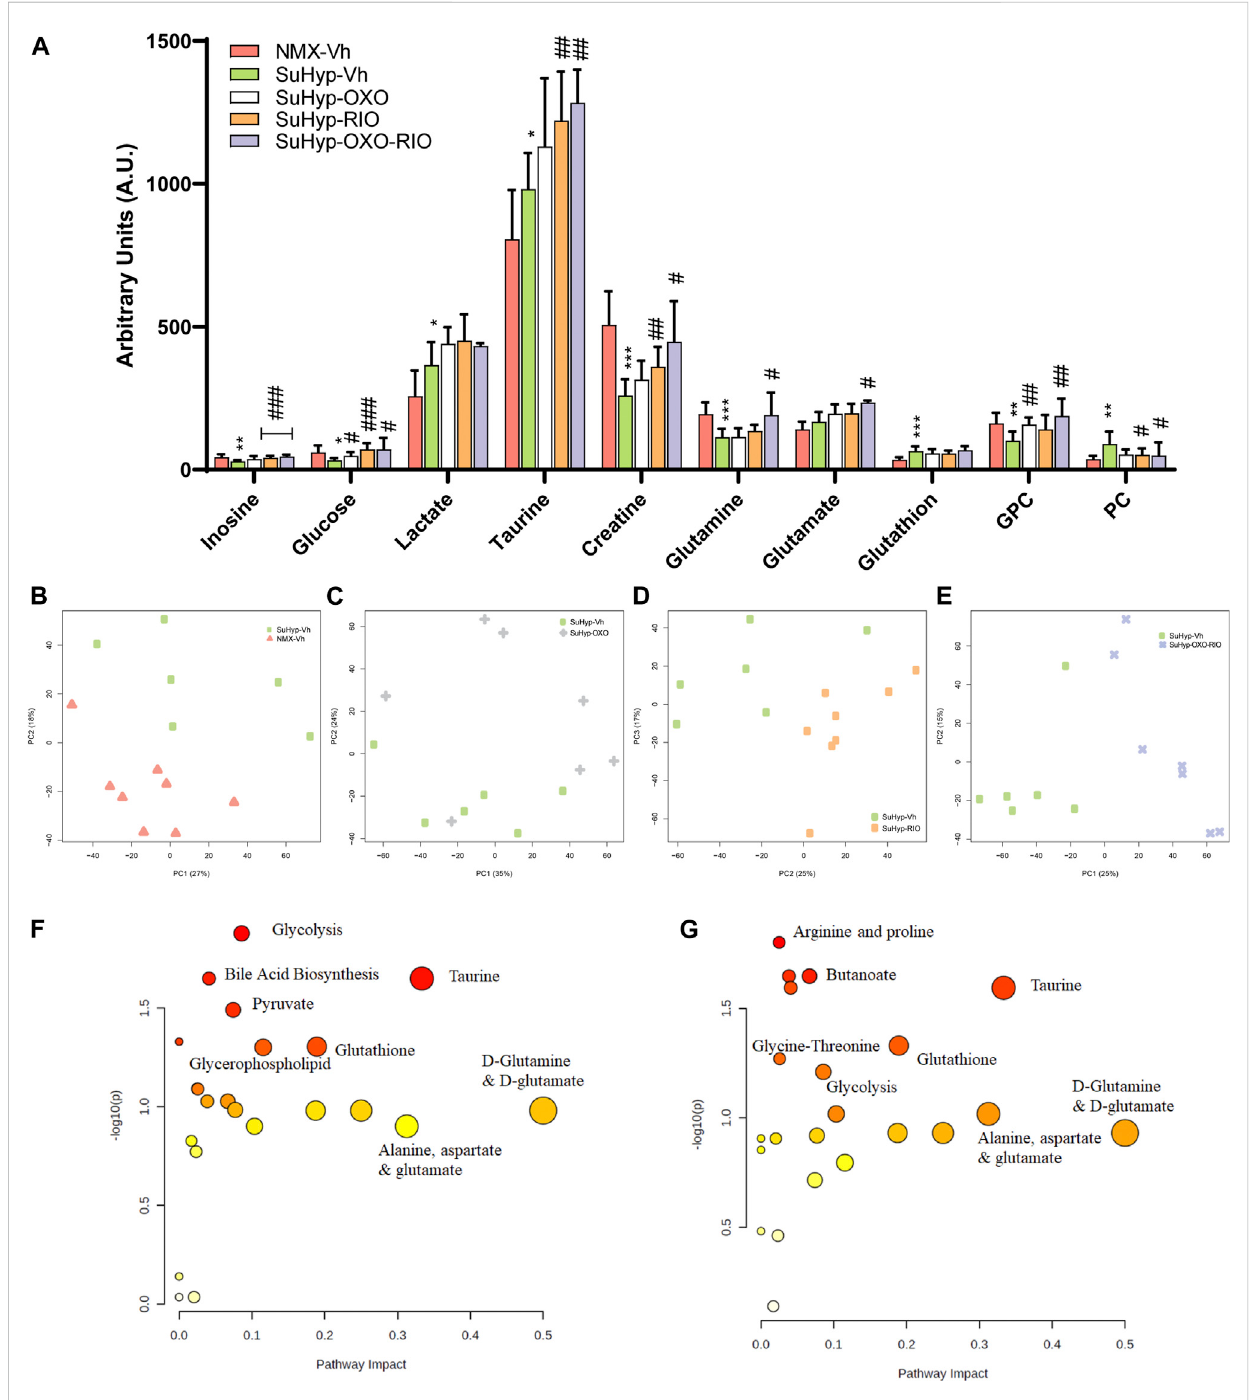
FIGURE 3 Treatment with riociguat and 5-Z-7oxozeaenol reduces metabolic reprogramming in the right ventricle (RV) from SuHyp rats. (A) Metabolomic pro fi ling of RV samples showing the quanti fi cation of metabolites signi fi cantly altered between the fi ve intervention groups. Statistical signi fi cance was determined using a Bonferroni-corrected Student ’ s t-test (* p < 0.05 versus normoxia + vehicle and # p < 0.05 versus SuHyp + vehicle). (B) Metabolic pro fi ling of RV samples discriminated between SuHyp and control groups as shown by principal components analysis (PCA) performed on 1 H-MRS data. Treatment with (C) 5Z-7-oxozeaenol, (D) riociguat or (E) both drugs combined induced a signi fi cant metabolic shift in the SuHyp RV. (F) Metabolic pathway analysis of the set of metabolites found to be signi fi cantly dysregulated between control and SuHyp rats (G) Incidence of the combined treatment with 5Z-7-oxozeaenol and riociguat on the SuHyp group over the speci fi c metabolic pathways. Y -axis represents the statistical p values from enrichment analysis, and the X -axis represents the pathway impact value calculated from pathway topology analysis. The node colors represent the p -values (lowest: light yellow; highest: dark red) and the node radius indicate the pathway impact values. Dysregulated metabolic pathways are labeled. Control group: NMX-Vh, Sugen 5,416/hypoxia: SuHyp, SuHyp + 5Z-7-oxozeaenol treatment: SuHyp-OXO; SuHyp + riociguat treatment: SuHyp-RIO; SuHyp+ 5Z-7-oxozeaenol and riociguat treatment: SuHyp-OXO-RIO, PC: Principal Component, GPC: Glycero-phosphocholine and PC: